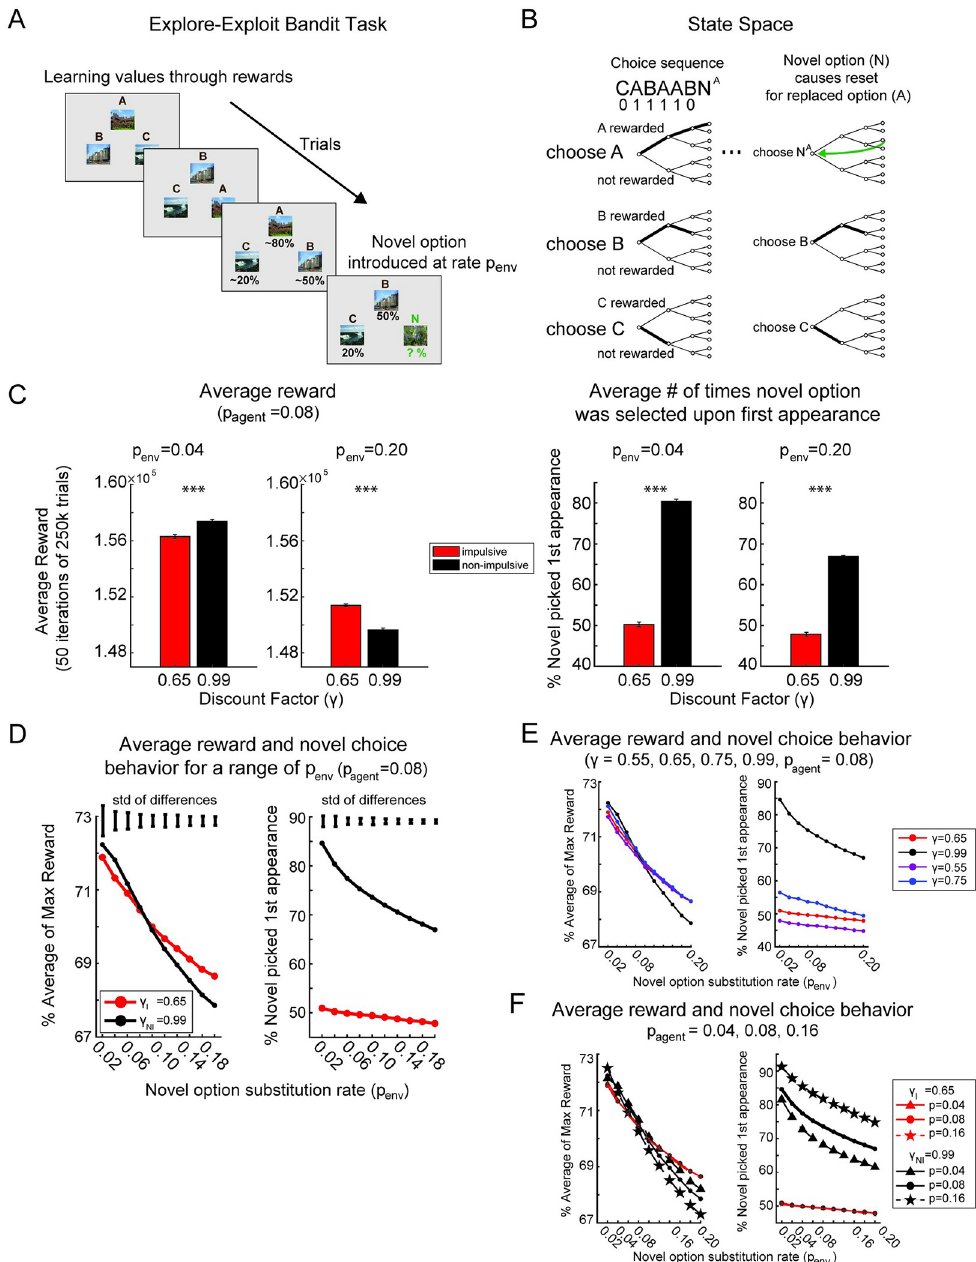
Fig 5. Explore-Exploit bandit task with novelty. A) Example sequence of trials in the Explore-Exploit task. In this example, each option (A, B, C) is a picture with an underlying reward rate. The agent or participant must learn the values of the three options through experience of choosing the options and receiving or not receiving a reward on each trial. In this example, the agent has learned the approximate values of the options over the course of multiple trials (not all are shown) and then a novel option is substituted for one of the options (option A). The novel option substitution rate (p env ) affects the number of trials the agent has to learn about an option. When p env is high, it is harder for the agent to learn about the underlying values of the options. B) State space representation of the Explore-Exploit task. Each option can be represented with a separate subtree. Thus, for an example sequence of choices such as C, A, B, A, A, B, the agent progresses through 1 step of the tree for C, three steps for A, and two steps for B. The agent progresses to an upper branch or lower branch depending on whether the choice was rewarded. Rewards are shown for this example sequence as 0s or 1s. Thus, the agent progresses through the uppermost branches of the subtree for option A, as it was rewarded all three times it was chosen. The introduction of a novel option causes the position in the subtree for that option to reset. When the novel option is presented at the end of this sequence and replaces option A, the agent jumps back to the start for that option,